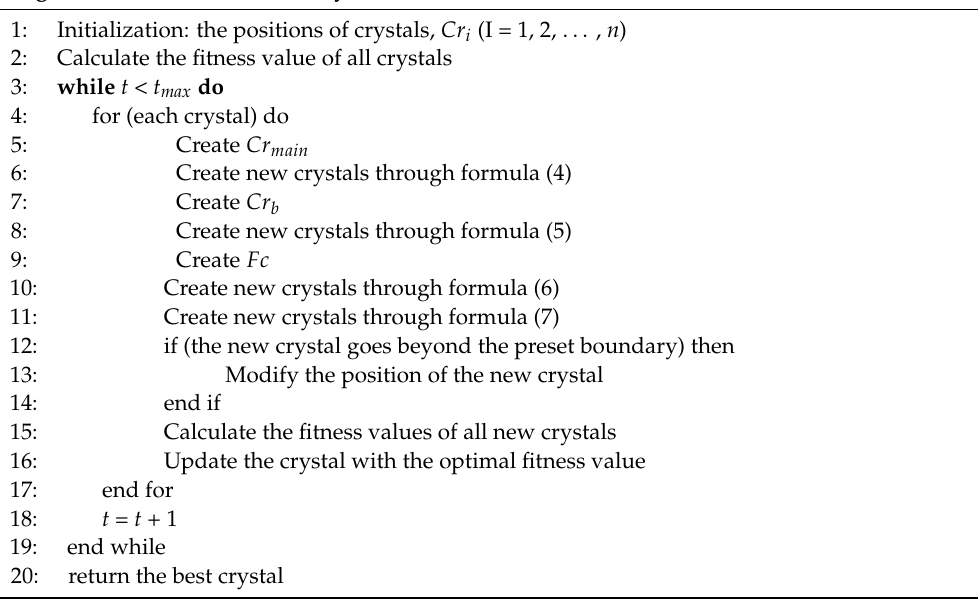
Algorithm 1. Pseudo-code of